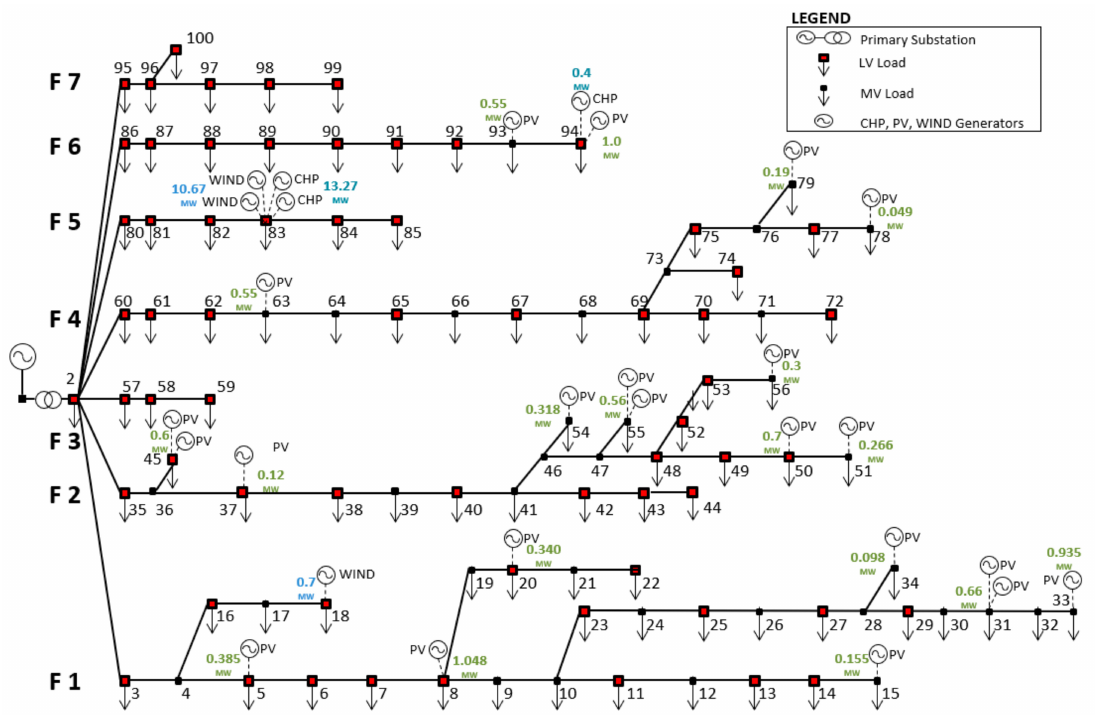
Figure 1. Test network (representative network derived from ATLANTIDE project